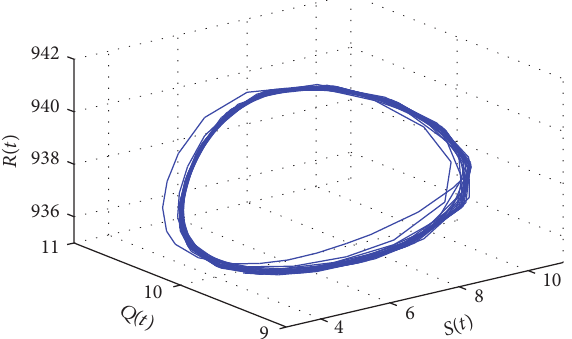
Figure 24: The phase plot of 𝑆 , 𝑄 , and 𝑅 when 𝜏 2 = 1.52 > 1.3485 = 𝜏 󸀠 20 and 𝜏 1 = 0.65